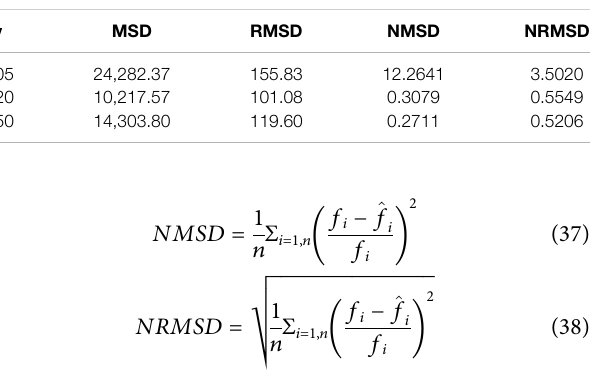
TABLE 5 | Comparison of fl ows explicit weibit vs. implicit weibit.